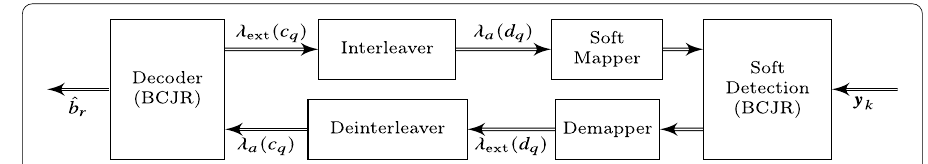
Fig. 3 Iterative decoding on the receive path of the system